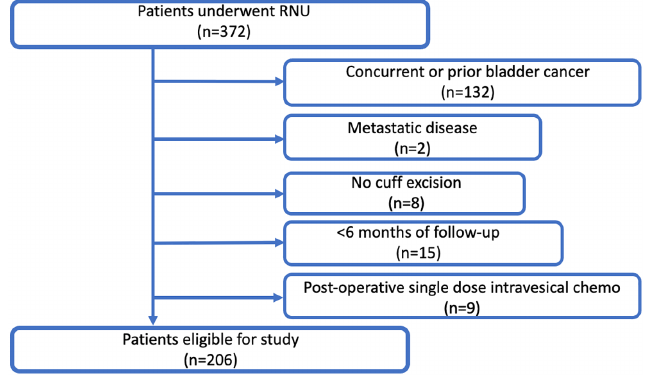
Figure 1. Study flowchart for inclusion criteria. RNU: radical nephroureterectomy